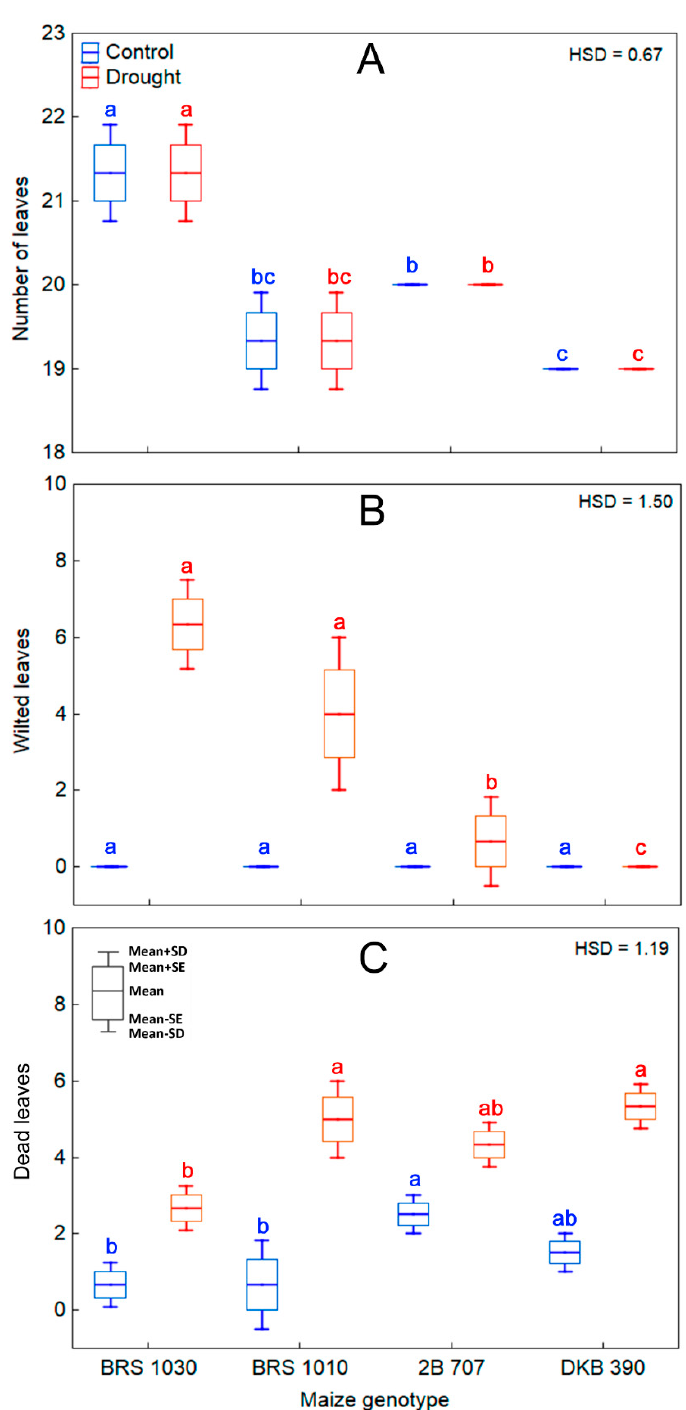
Figure 9. Drought e ff ects on total, wilted and dead leaves of maize genotypes. ( A ) Number of total ( B ) wilted and ( C ) dead leaves in plants of maize genotypes grown in soil at field capacity (control) or subjected to water shortage (drought) at pre-flowering stage. ( A – C ) showed significant interaction between treatment and genotype ( p < 0.05) which indicates that the means of the genotypes should be compared by treatment. Boxes from di ff erent genotypes under the same treatment, topped by the same letter, are not statistically di ff erent according to Tukey’s test ( p < 0.05).